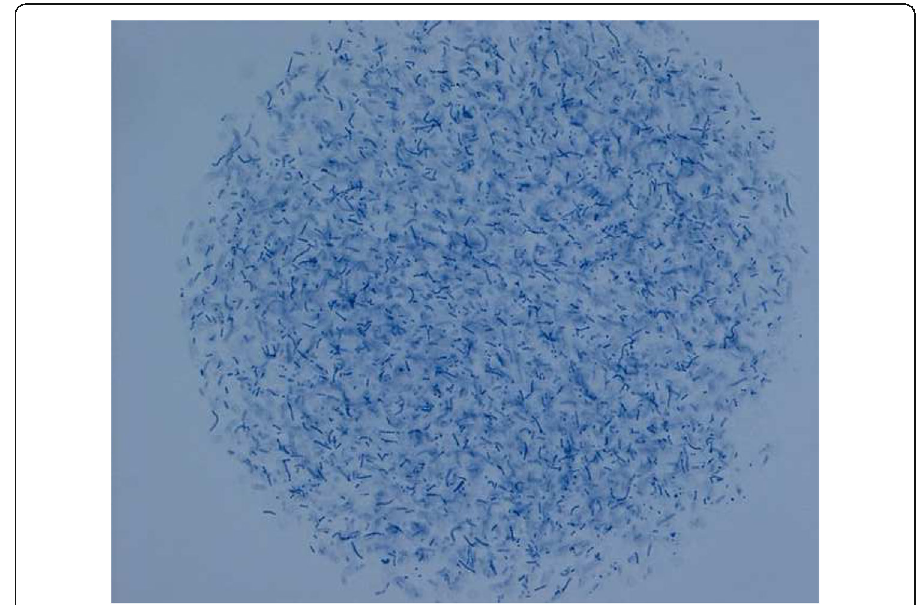
Fig. 1 Streptococcus pneumoniae embedded in an agar bead. Richardson staining, × 400 magnification. Agar beads with Streptococcus pneumonia have a diameter of 50 – 200 μ m. The size of these S.